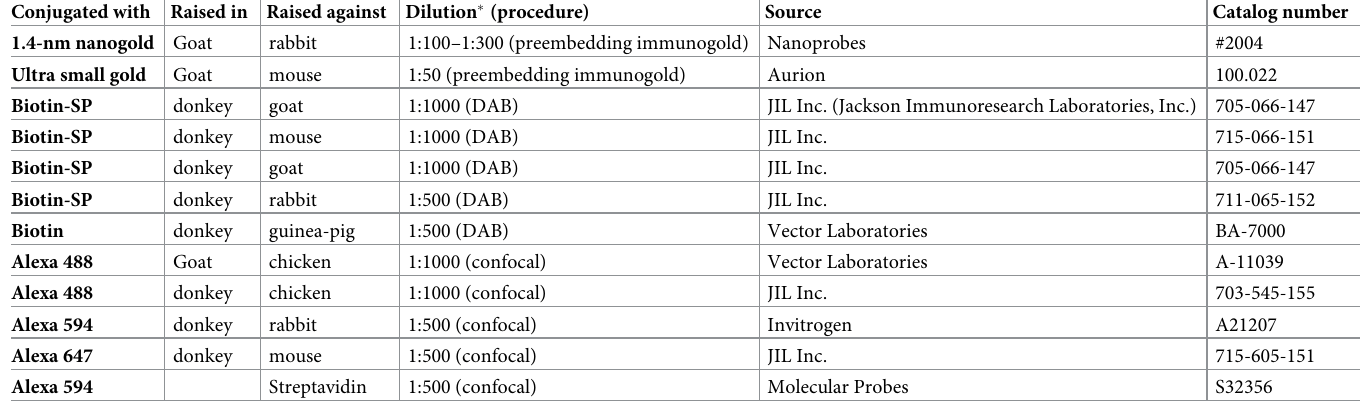
Table 2. Secondary antibodies. Conjugated with Raised in Raised against Dilution �